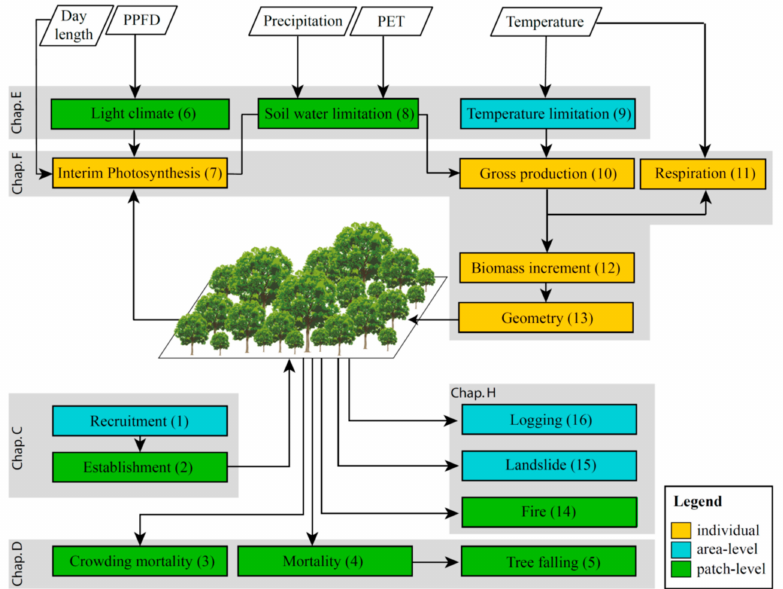
Figure 3. Mechanism of FORMIND [40]. For more information, see FORMIND Handbook